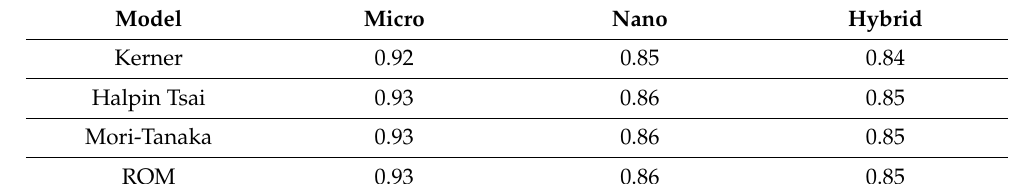
Table 5. Comparison of regression (R 2 ) between model and experimental data.